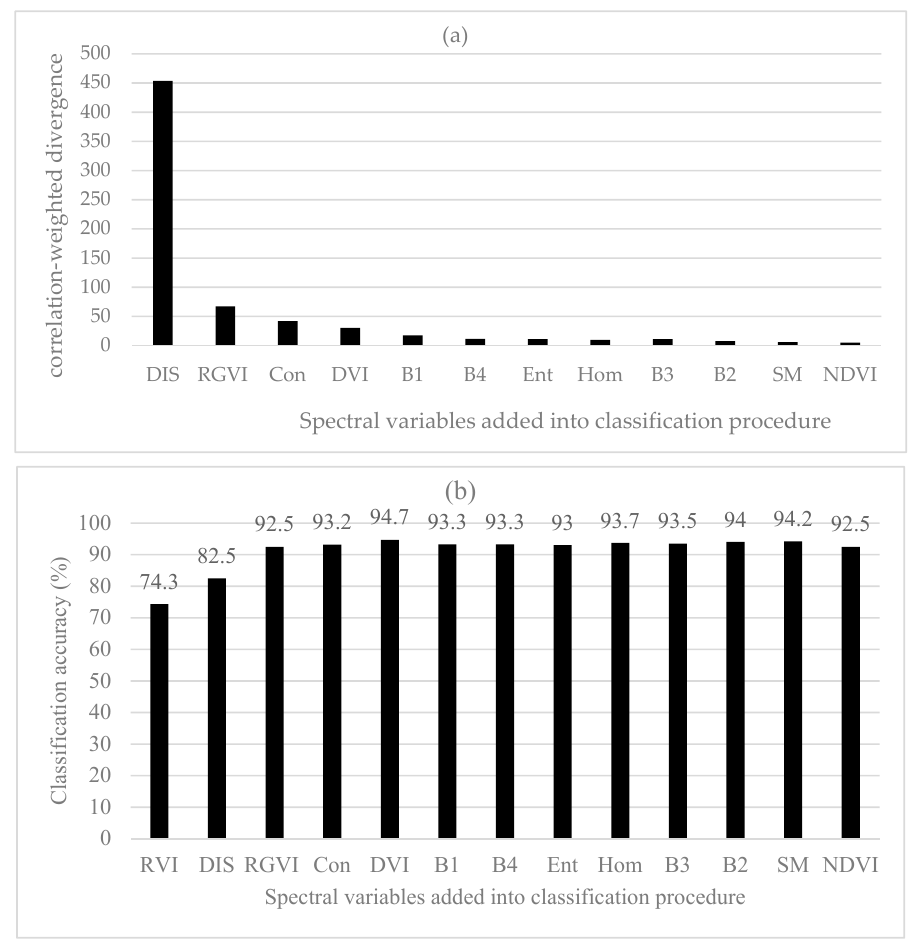
Figure 5. ( a ) Correlation-weighted divergences of the left 12 spectral variables selected after the first spectral variable RVI; and ( b ) the classification accuracies of six land cover types using Bayesian discriminant ( BD ) classifier as the spectral variables orderly added based on the correlation-weighted divergences.